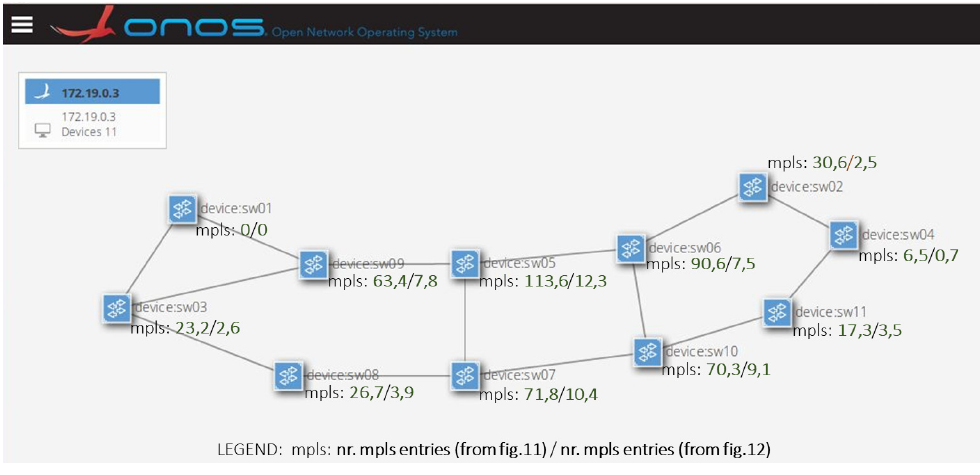
Figure 10. Abilene network topology from the Internet network topology zoo